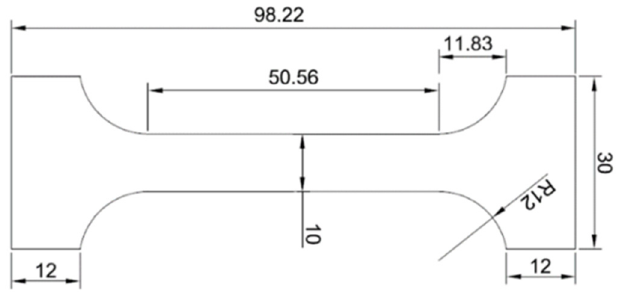
Figure 1. Test piece of a solder for a static tensile test.